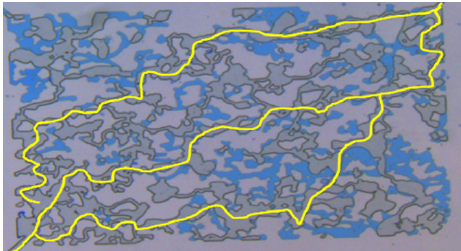
Figure 8. Gas channeling caused by heterogeneity of porous media, 50 μ m model.